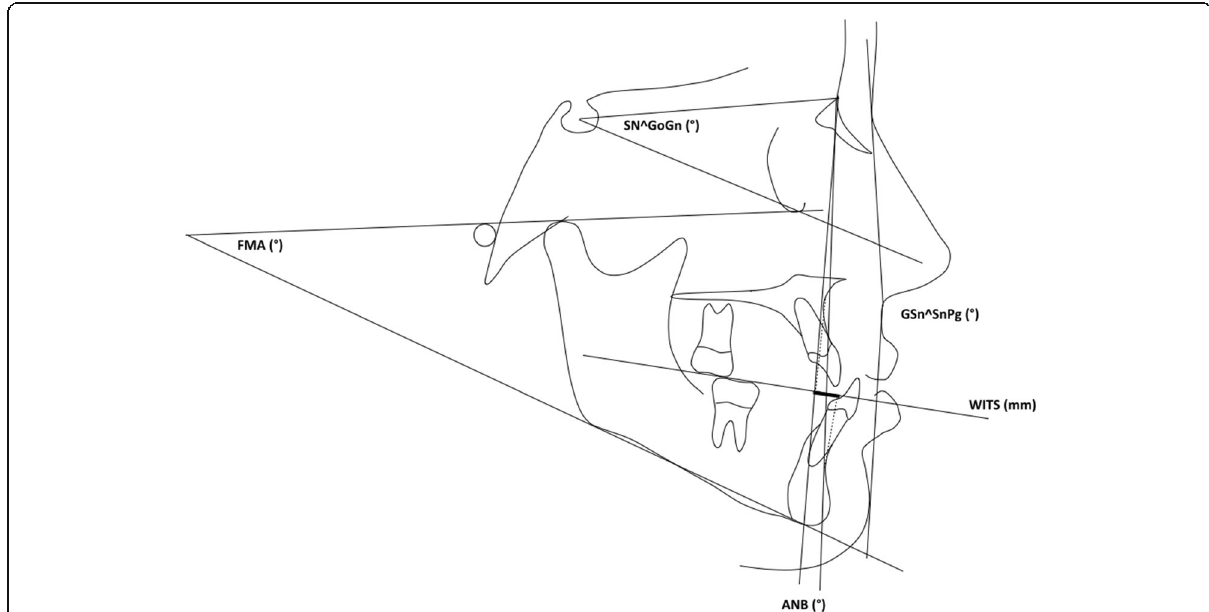
Fig. 1 Angular and linear measurements performed at pre-treatment and post-treatment phase on lateral cephalometric radiographs